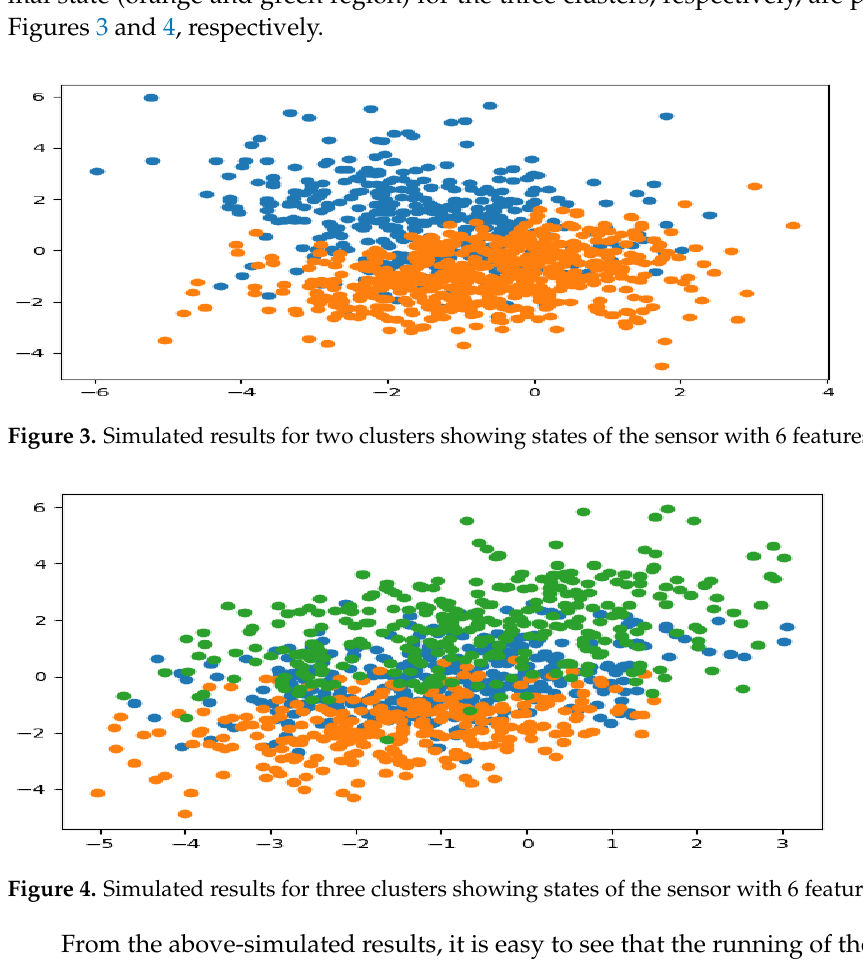
Figure 2. Simulated results for the three clusters showing two states of the sensor with 2 features. Similarly, the K-mean clustering algorithm was implemented for the six (6) features of the sensor by using the same test dataset of 1000 samples over the same period. The simulated results showing the fault state (blue region) and the non-fault state (orange region) for the two clusters and the normal state (blue region) and the abnormal state (orange and green region) for the three clusters, respectively, are presented in Figures 3 and 4, respectively.